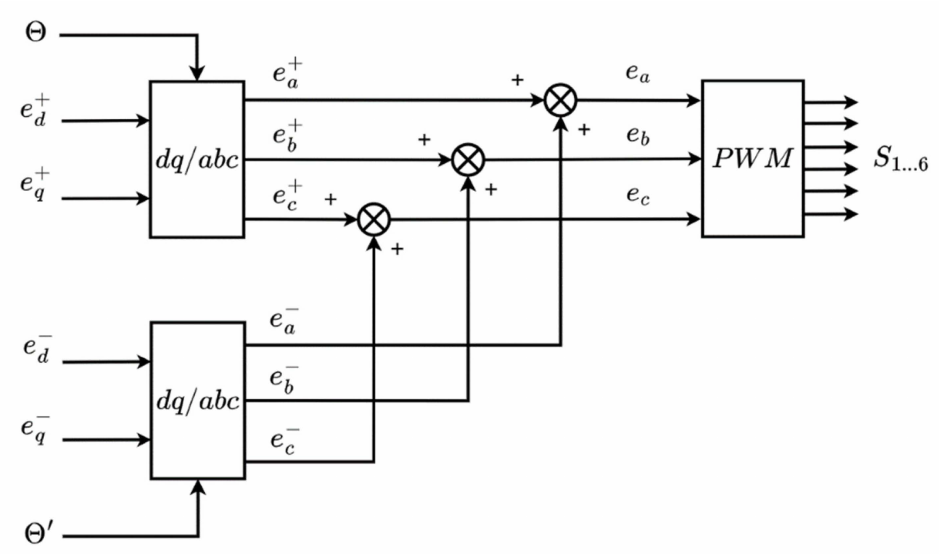
Figure 13. Converter voltage setpoints